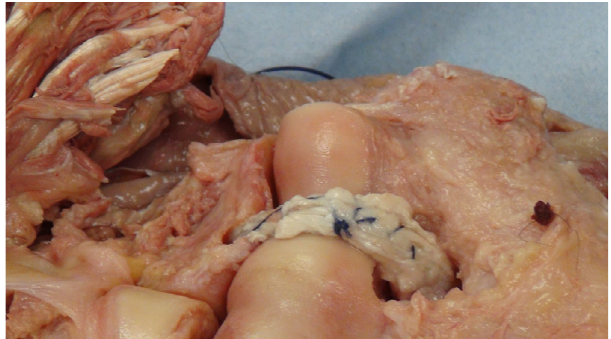
Figure 6. Anterior view of the graft in its final position.